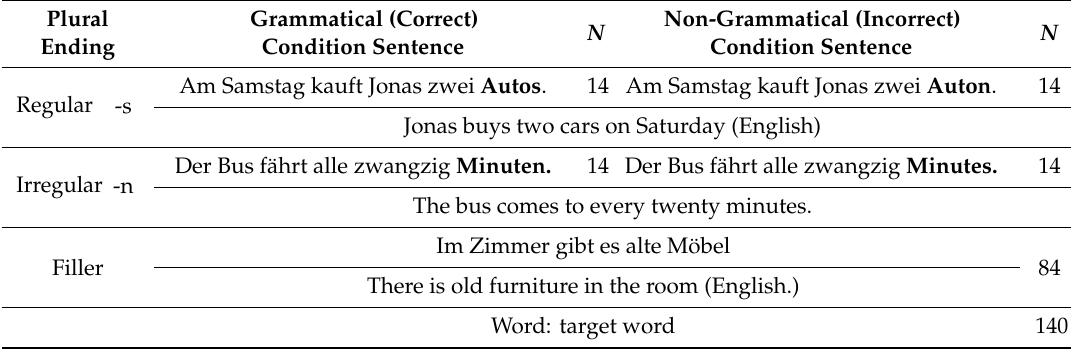
Table 2. Example